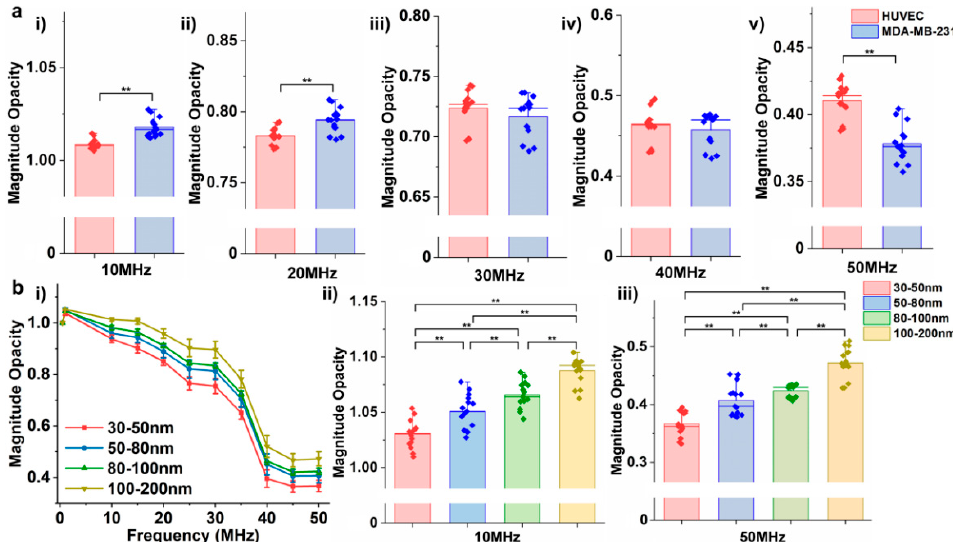
Figure 7. The magnitude opacity comparison of EVs extracted from ( a ) human umbilical vein endo- thelial cells (HUVECs) and epithelial human breast cancer (MDA-MB-231) cells. (** P < 0.05, n = 15.) ( b ) ( i ) Magnitude opacity spectrum of EVs at different size ranges isolated from an MDA-MB-231 cell line by ExoTIC. ( ii , iii ) Bar plots of magnitude opacity comparison of four EVs subsets at 10 MHz and 50 MHz. (** P < 0.05, n = 15.)